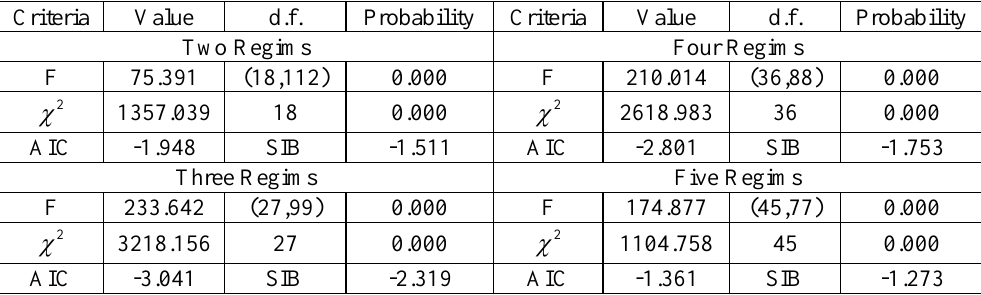
Table 3. The Log-Likelihood Ratio Test Results